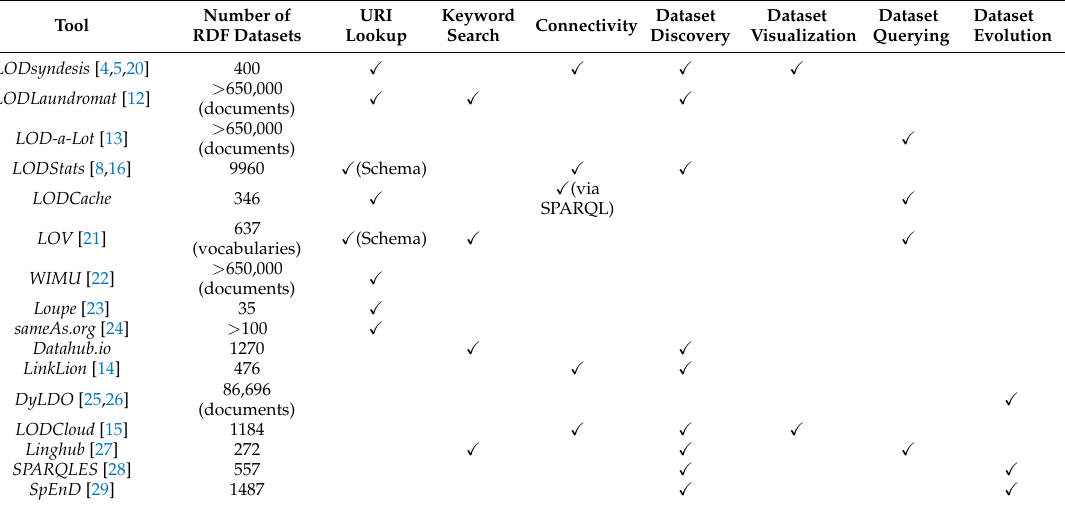
Table 1. Global RDF cross-dataset services (last accessed date: 3 May